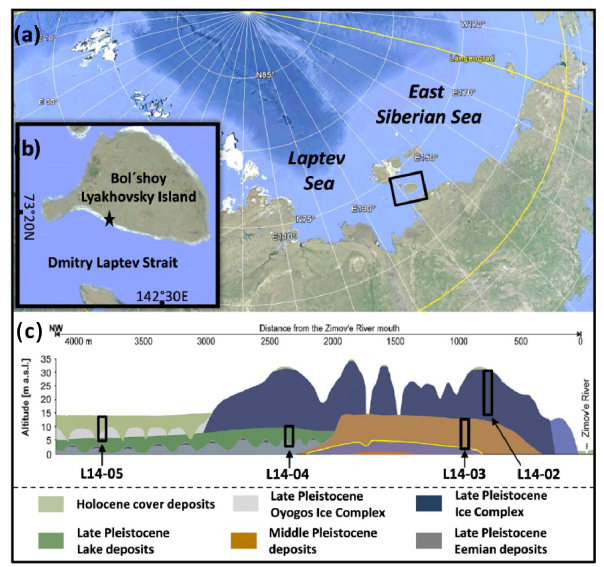
Figure 1. (a) Position of Bol’shoy Lyakhovsky Island in the Siberian Arctic. (b) Study site on Bol’shoy Lyakhovsky Island indi- cated by a black star and (c) location of the drilled cores compris- ing different age intervals (L14-05, L14-02, L14-03, and L14-04) modified after Wetterich et al. (2009, 2014) and Schwamborn and Wetterich